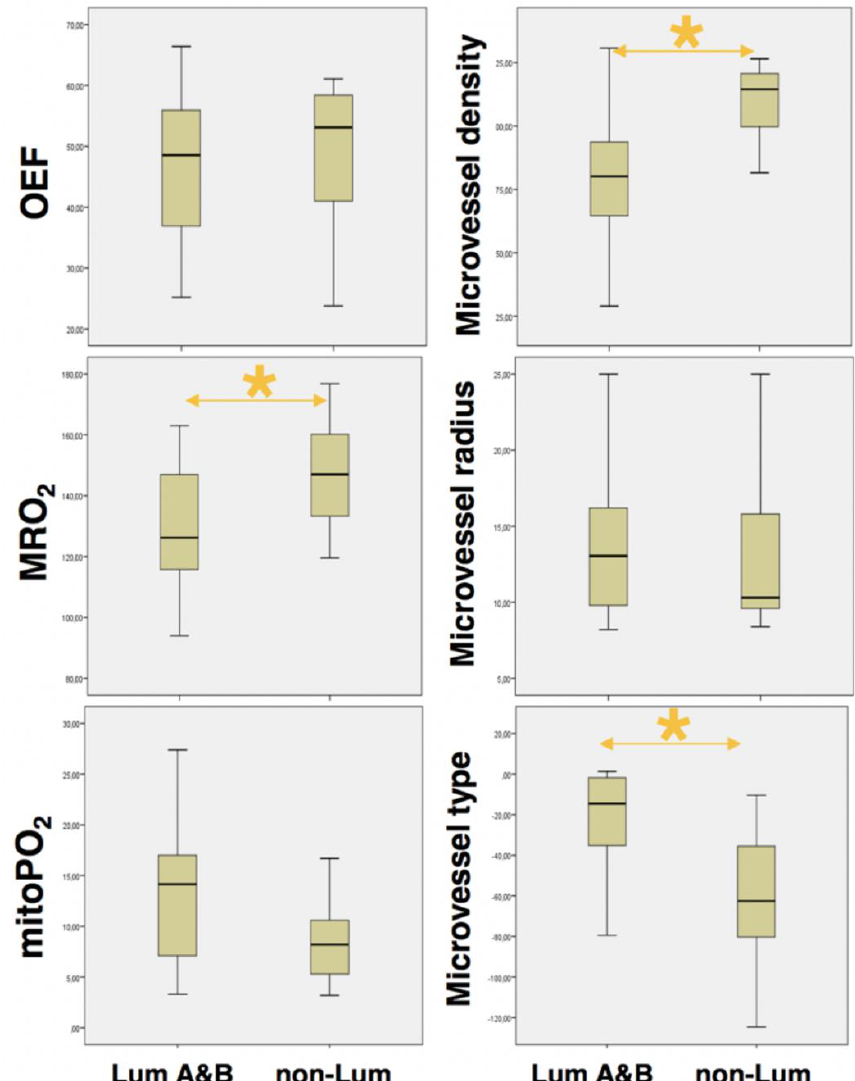
Figure 3. Box and whisker plots show the imaging biomarkers for luminal (A and B) and non-luminal (HER-2 positive and TN) tumors. Boxes are mean values ± standard deviations, and whiskers indicate minimum and maximum values. * indicates statistical significance ( p < 0.05).